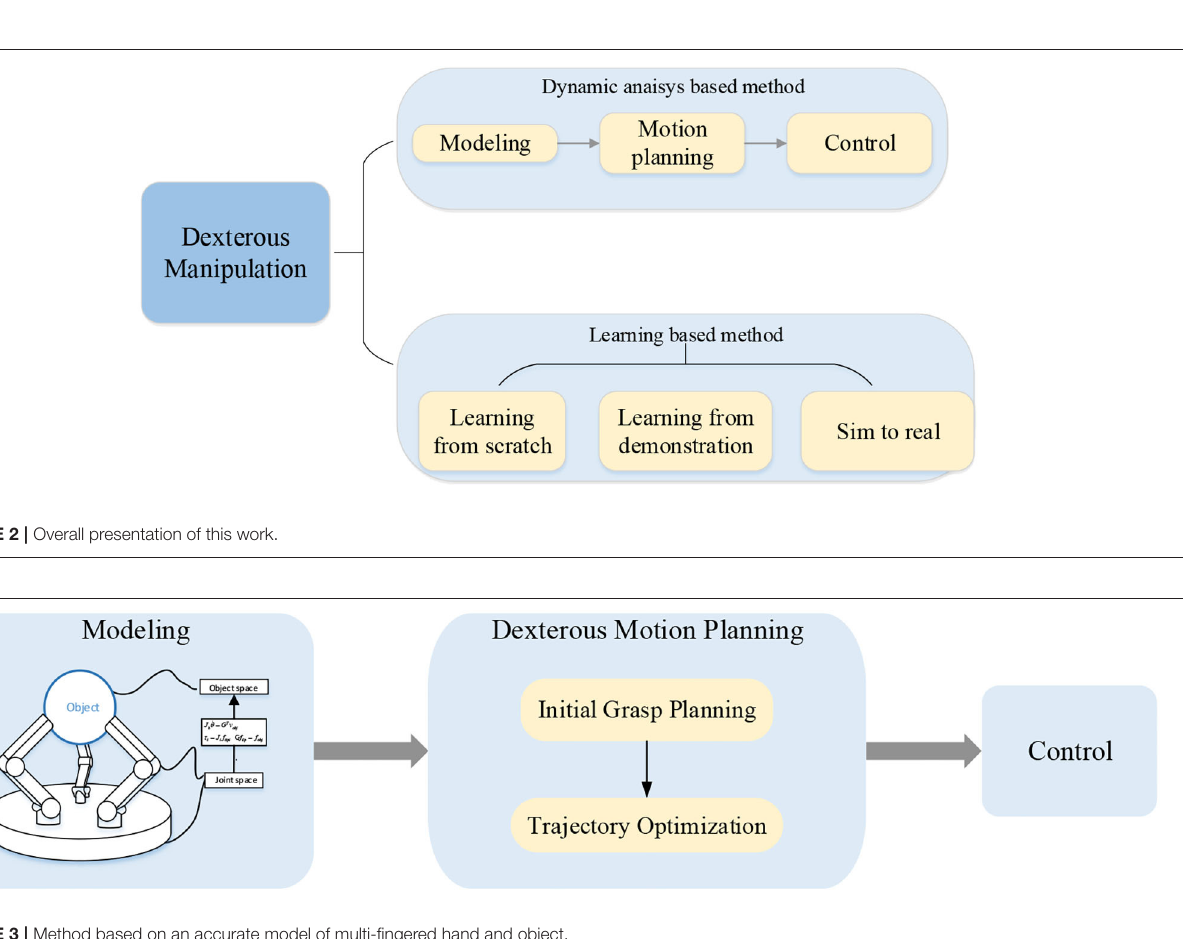
FIGURE 3 | Method based on an accurate model of multi-fingered hand and